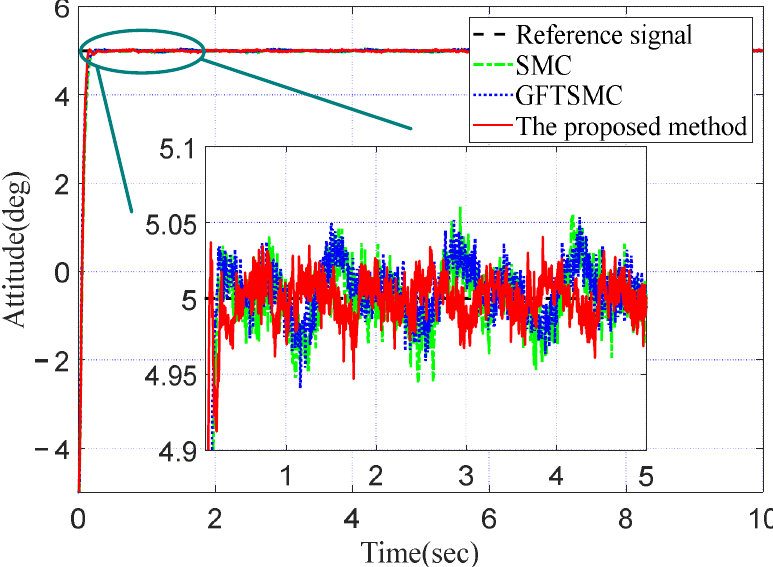
Figure 3. The control performances of different control methods.